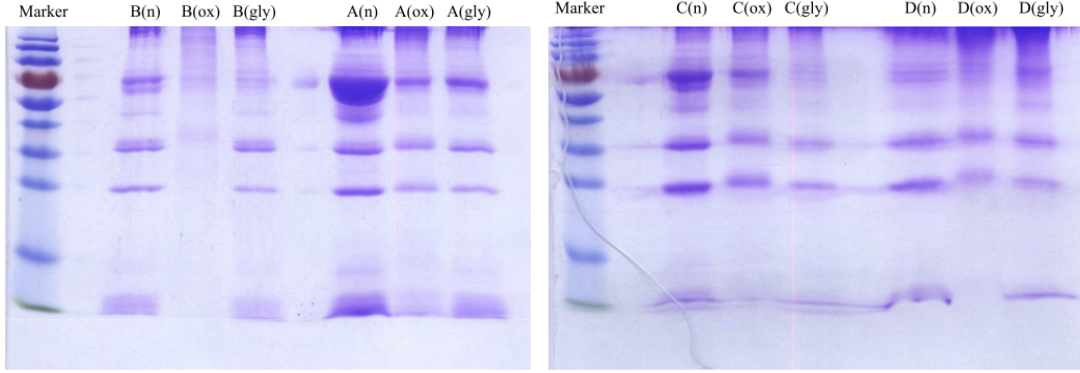
Figure 4. Sodium dodecyl sulfate polyacrylamide gel electrophoresis (SDS–PAGE) analysis of native (n), in vitro oxidized (ox) and glycated (gly) VLDL fractions of four healthy